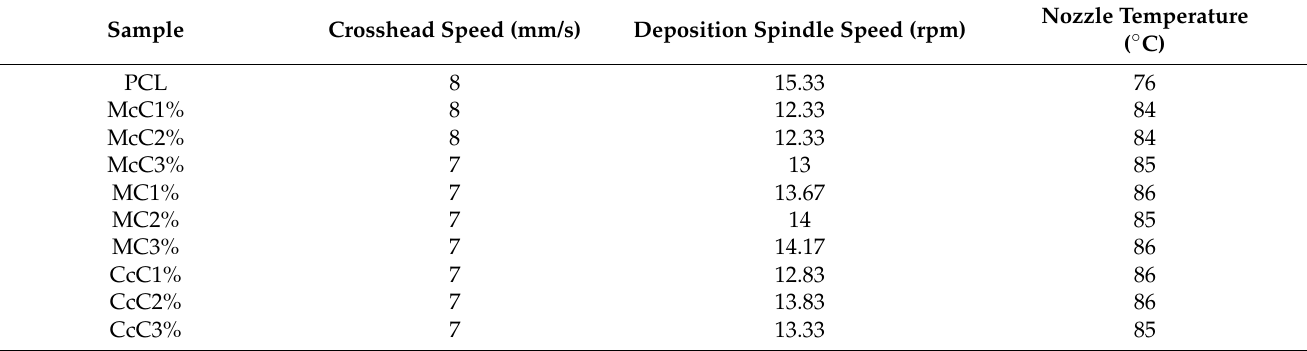
Table 2. Parameters of the equipment used in the extrusion of each PCL–cellulose